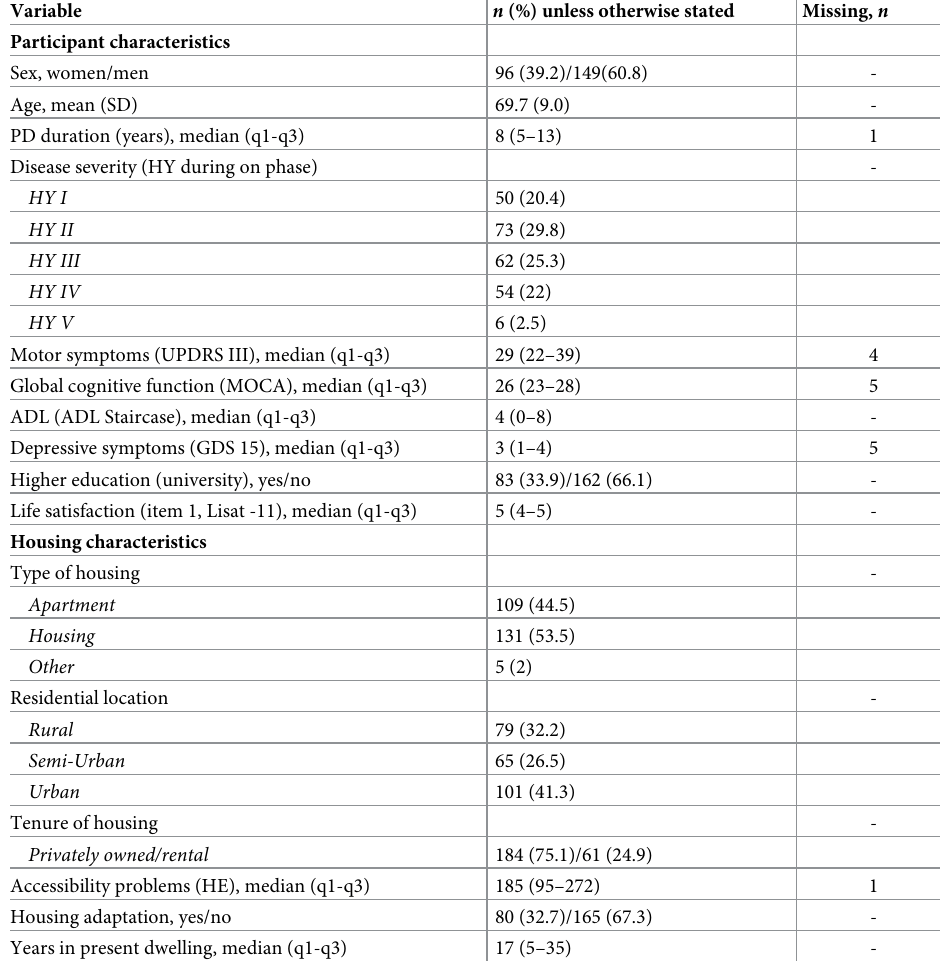
Table 1. Sample characteristics, N =